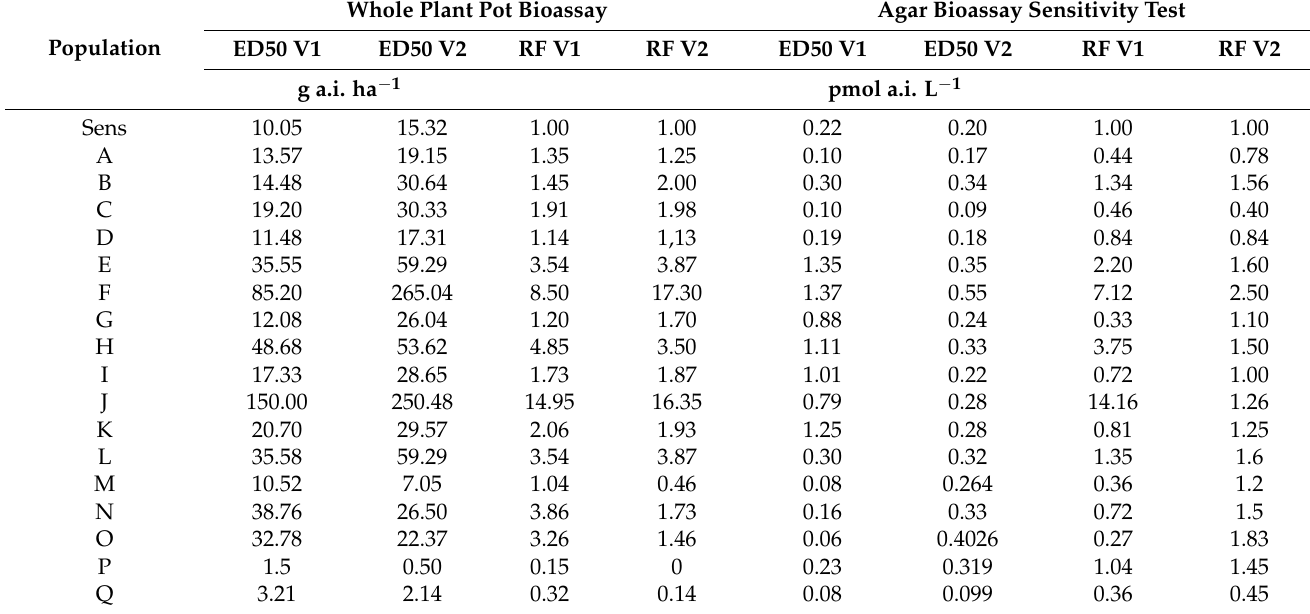
Table 1. Evaluation of sensitivity of the A. myosuroides populations to cinmethylin in a whole plant pot bioassay in green- house and agar based resistance test under controlled environmental conditions in a climate chamber. ED50 = herbicide dosage causing 50% reduction in the relative dry matter content and RF = resistance factor. V1 = experiment one, V2 = experiment 2. Whole plat pot bioassay V1: lack-of-fit, p = 0.03; V2: lack-of-fit, p = 0.02; Agar bioassay